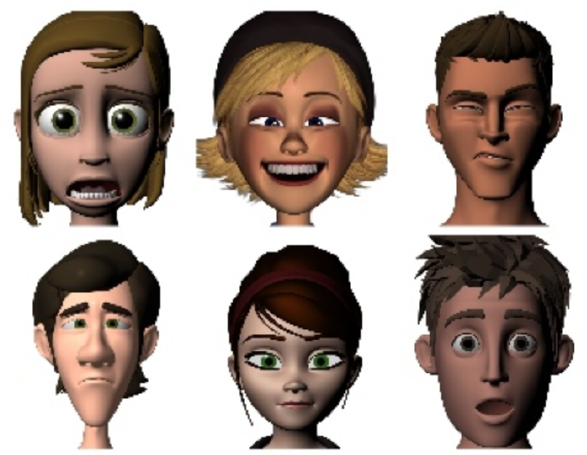
Figure 7. Six sample images from the FERG